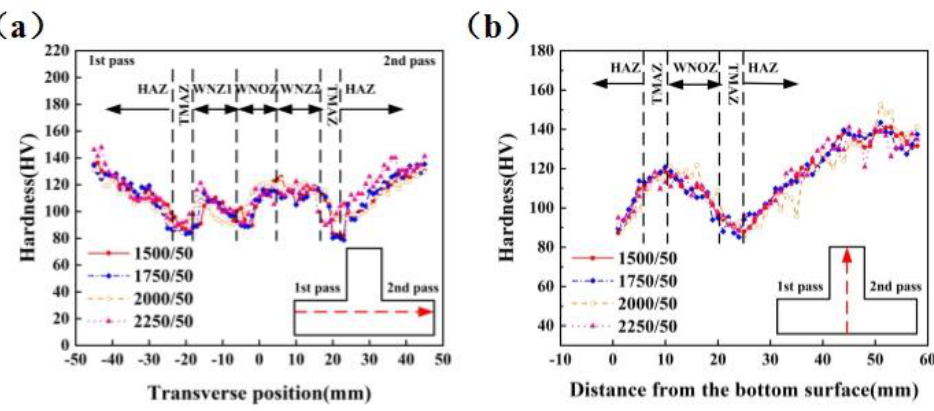
Figure 10. Hardness variation with rotation speed in different plates: ( a ) base plate and ( b ) rib plate.